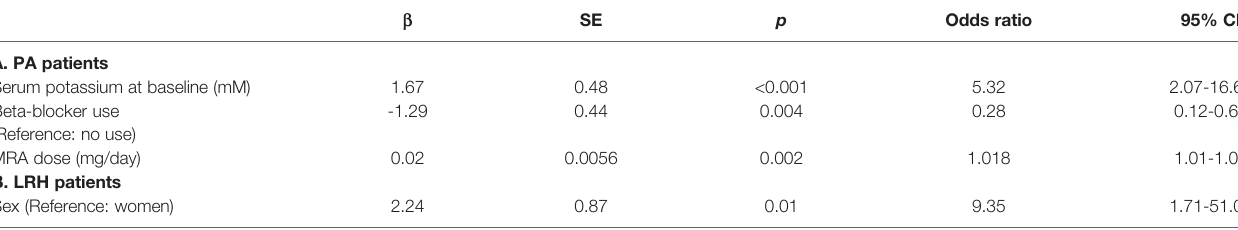
TABLE 3 | Factors associated with target renin achievement during MRA